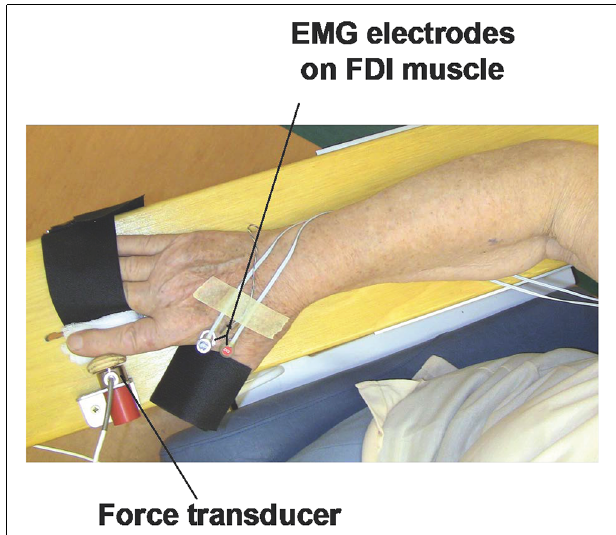
FIGURE 2 | Set-up for the unimanual index finger (UIFA) abduction motor